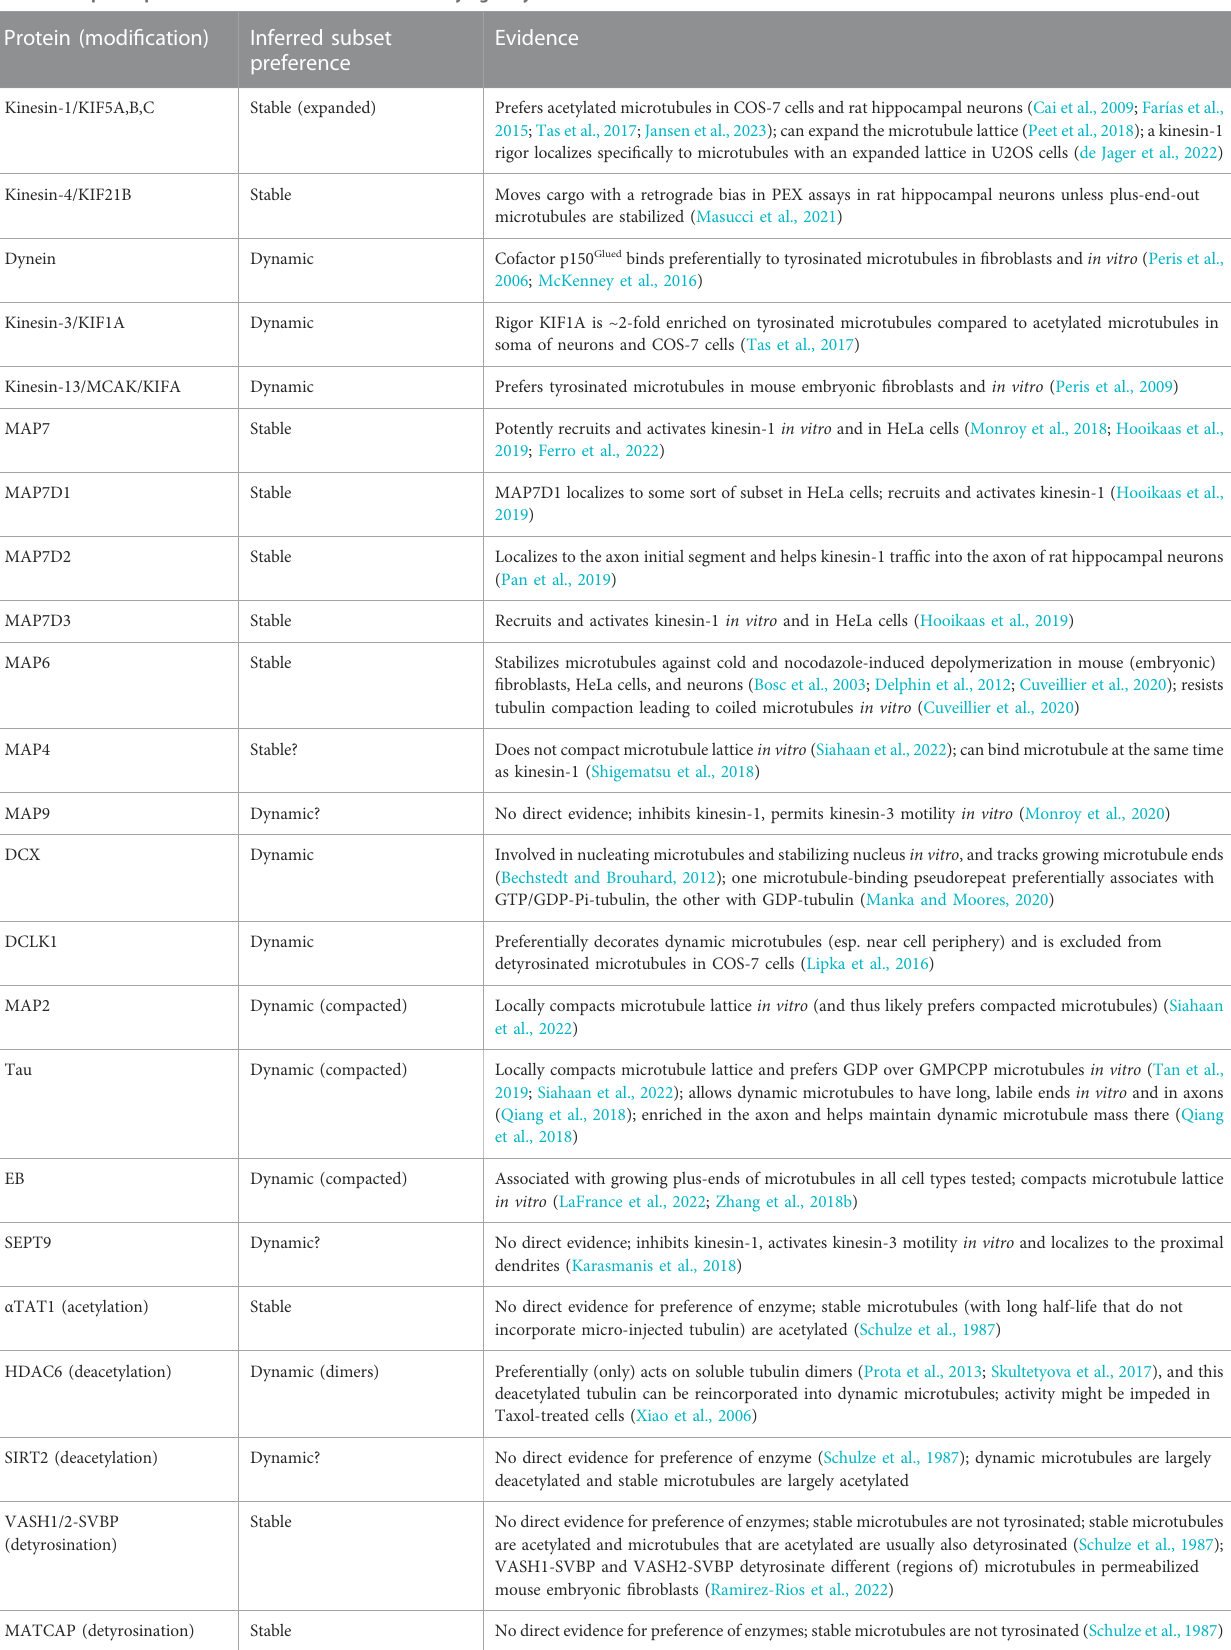
TABLE 1 Proposed preferences of MAPs and tubulin-modifying enzymes in neurons. Protein (modi fi